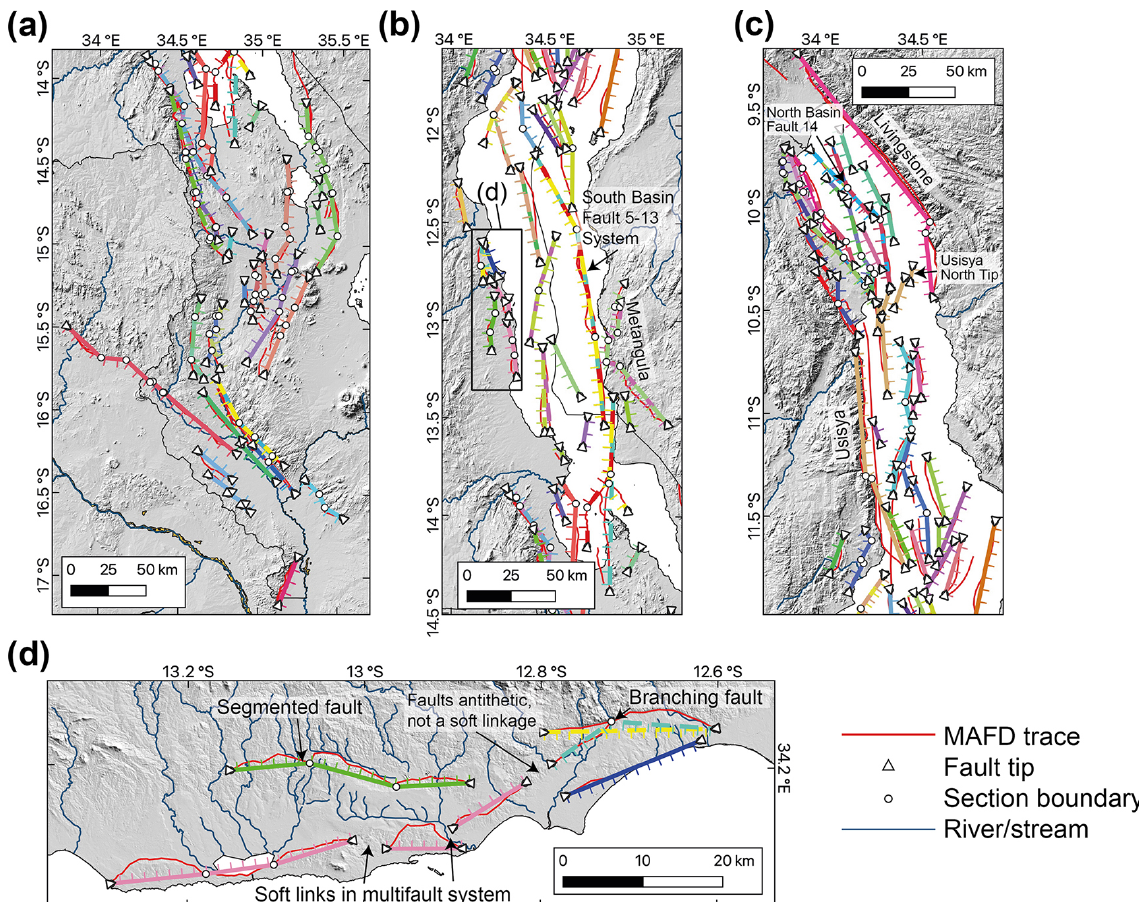
Figure 2. Maps for (a) southern Malawi and the (b) South Basin and (c) Central and North basins of Lake Malawi showing the simplified geometry of faults in the Malawi Seismogenic Source Model (MSSM). (d) Criteria used to define MSSM sources in central Malawi. The MSSM sources are connected by straight lines between fault tips (triangles) or section boundaries (circles) and coloured by each multifault or fault system. Soft links highlight where the across-strike distance between two synthetic fault sources is sufficiently small ( < 20% of combined fault length and < 10km) so that we interpret that they can simultaneously rupture and hence constitute a multifault source in the MSSM. Ticks indicate dip direction. Dashed or multicoloured sources indicate branching geometries. Thin red lines are the MAFD fault traces (Williams et al., 2022b), and they highlight instances where a MAFD fault is not included in the MSSM or where there is a discrepancy between the MAFD and simplified fault geometry in the